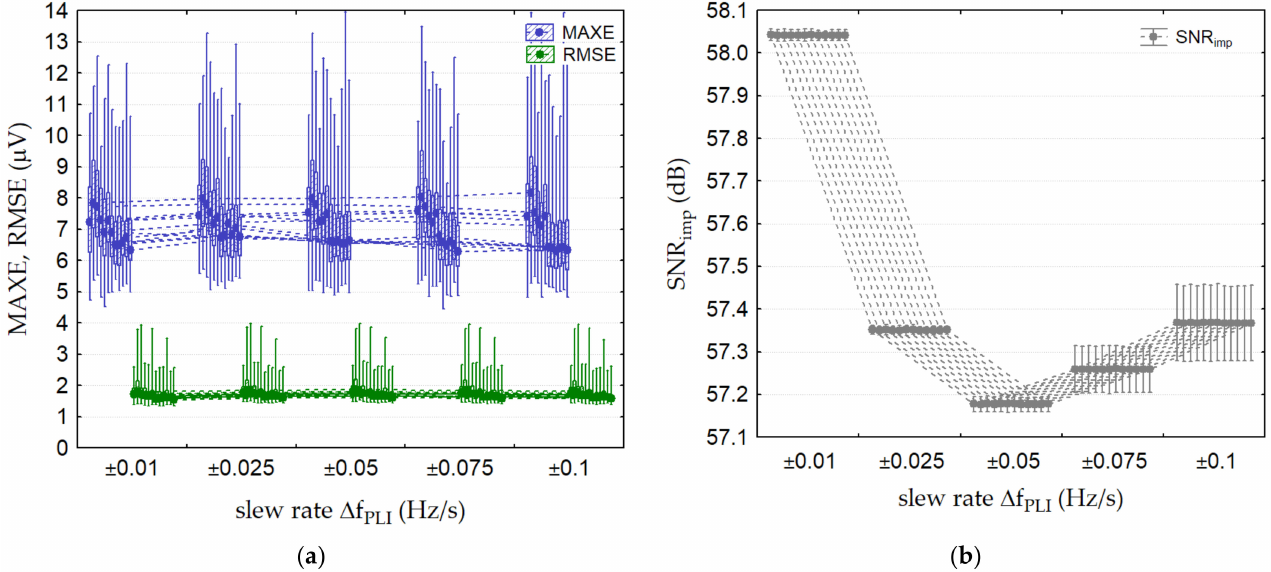
Figure 15. SF algorithm performance for PLI linear frequency change, computed for 10 s 12-lead ECG from the PTB Diagnostic ECG database and added PLI sinusoid with settings according to Table 2 (Test 5). The boxplots (median; box: 25–75%; whisker: min–max) represent: ( a ) MAXE and RMSE, ( b ) SNR imp ordered for 12 ECG leads (from left to right): I, II, III, avR, avL, avF, V1, V2, V3, V4, V5,